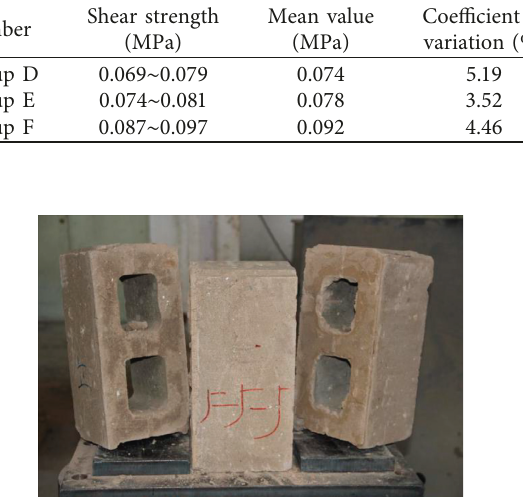
Figure 10: Typical failure mode of the masonry prisms tested under shear